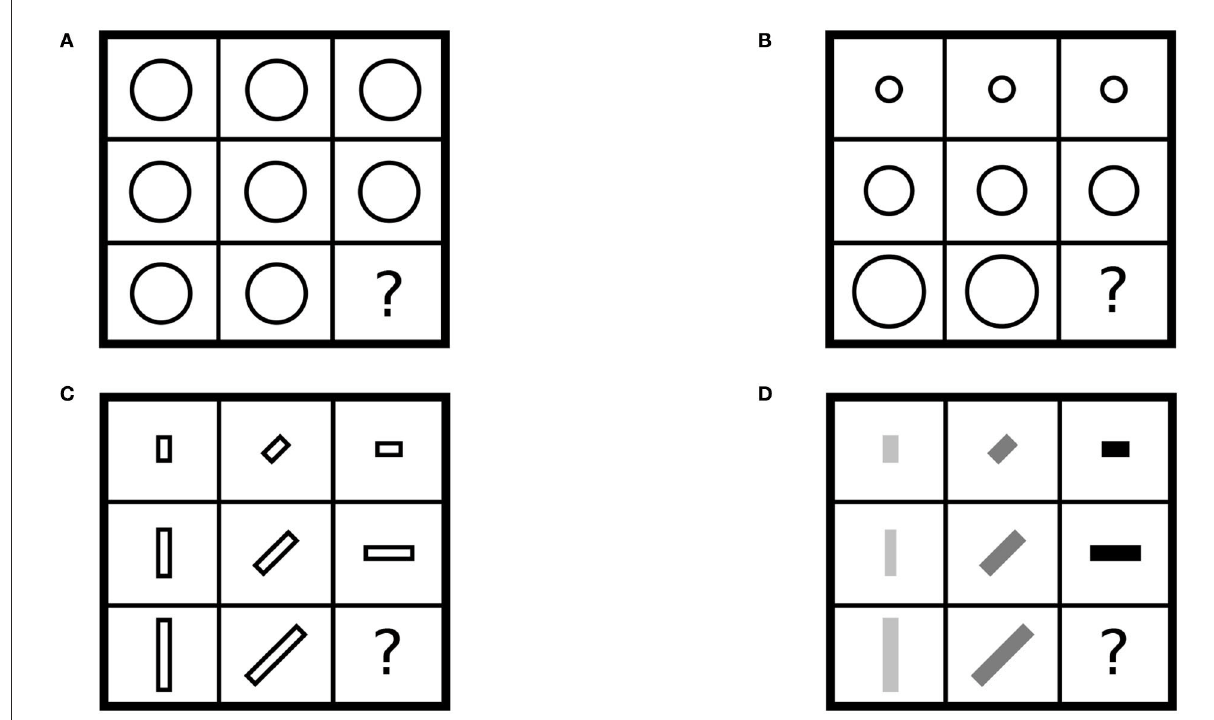
FIGURE9 Dimensions of variation in matrix reasoning: (A) zero, (B) one, (C) two, and (D)